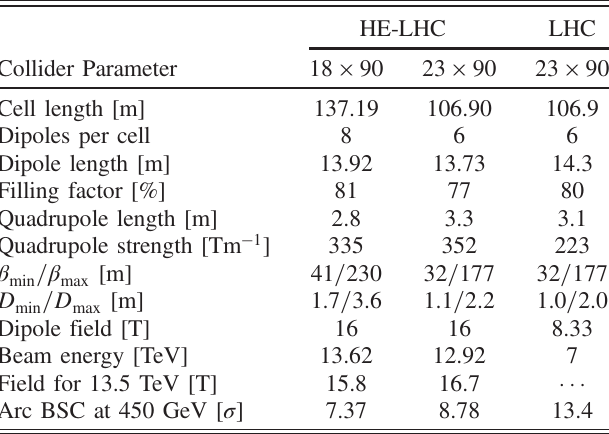
TABLE III. Parameters of the two HE-LHC design options, compared with the existing